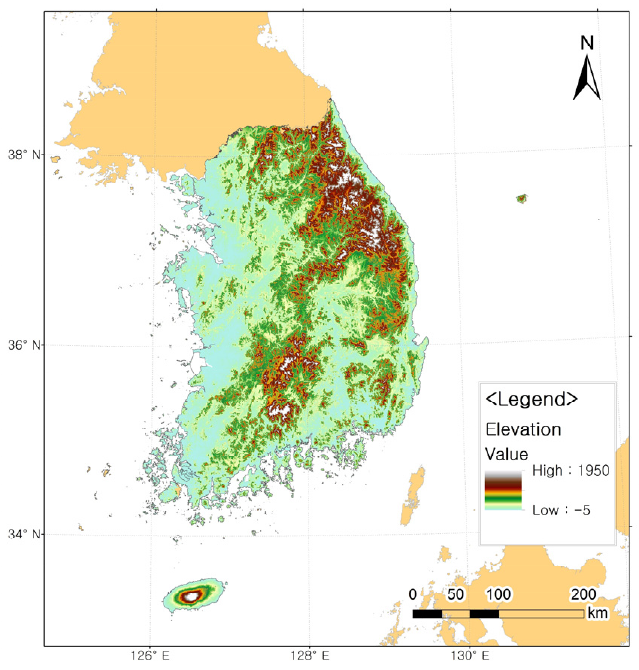
Figure 1. Study Figure 1. Study area.